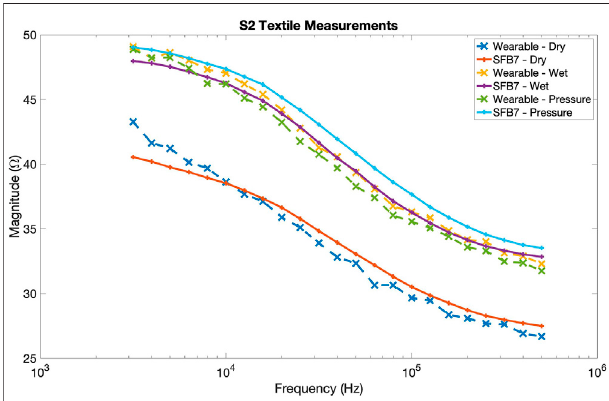
FIGURE 8 | Bioimpedance magnitude data for S2 (average of 5 runs) showing three different conditions for both the wearable bioimpedance measurement system and the commercial SFB7: dry textiles (dry), light pressureapplied totextiles usingmedicaltape(pressure), andlightlywet textiles (wet). The presence or absence of low frequency artifacts can be observedbycomparingthemeasurementsforthetwosystemsatfrequencies — below 15 kHz. The artifacts are worst for the dry condition, reduced for the pressure condition, and eliminated for the wet condition.